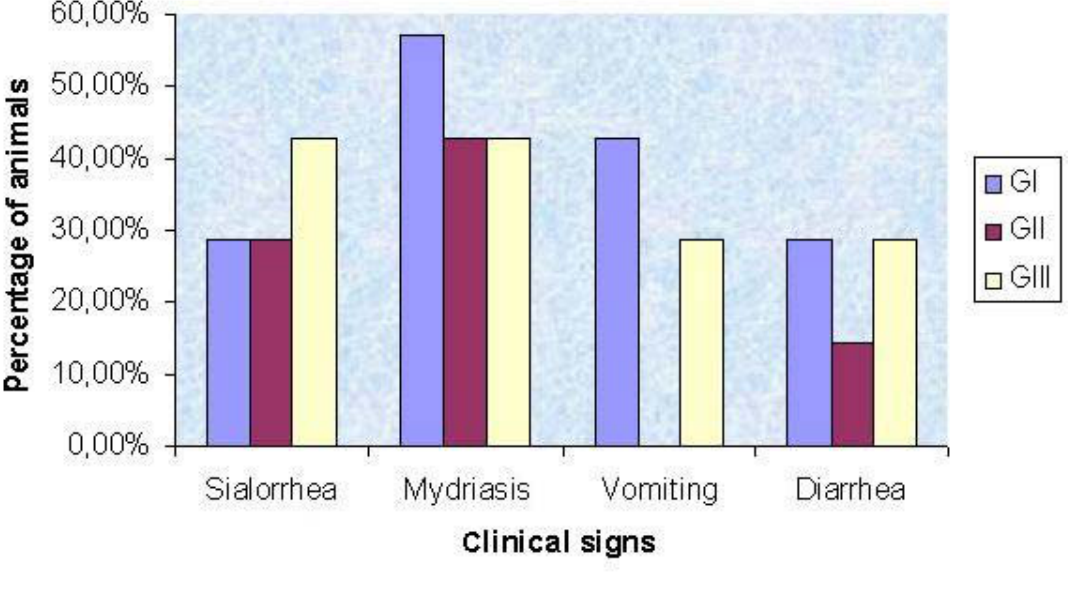
Figure 2. Percentage of animals that presented sialorrhea, mydriasis, vomiting and diarrhea at different moments after inoculation of crotalic